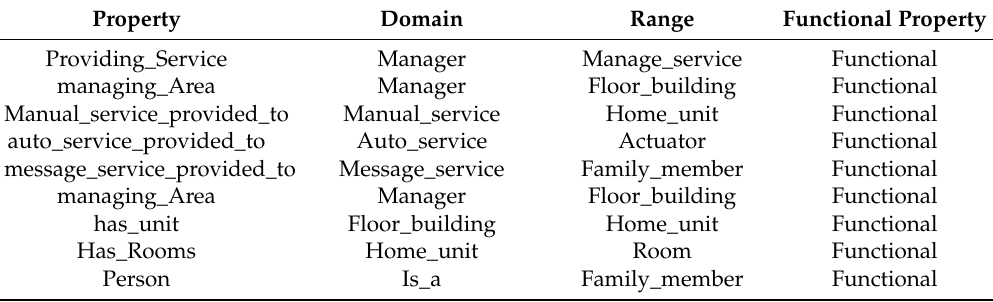
Table 3. Some property relationships between relevant classes from the perspective of